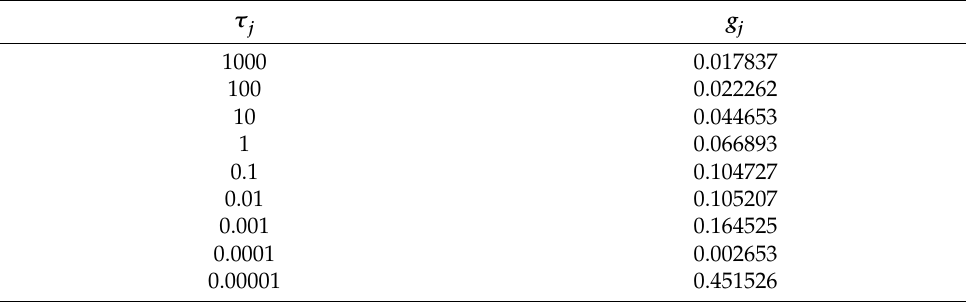
Table 2. Prony series parameters of the asphalt layer.